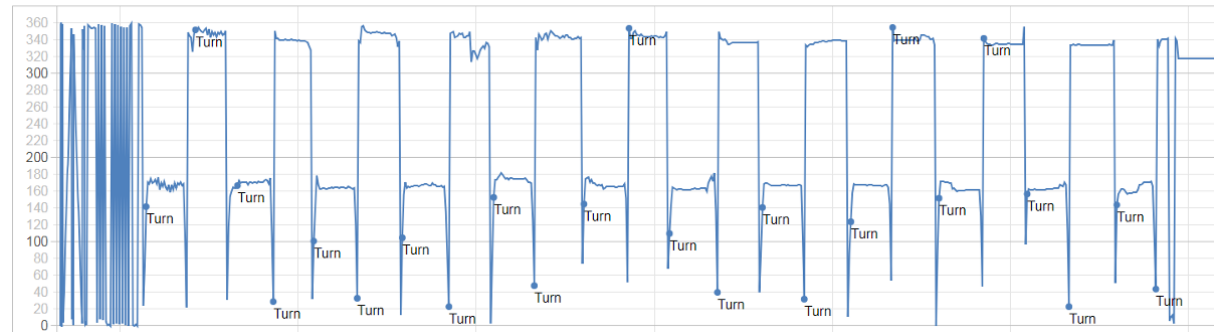
Figure 2. Example of mobile phone azimuth signal. The first seconds show the calibration phase, after which U-turns are detected when the difference between near angles becomes greater than the set threshold within a short time